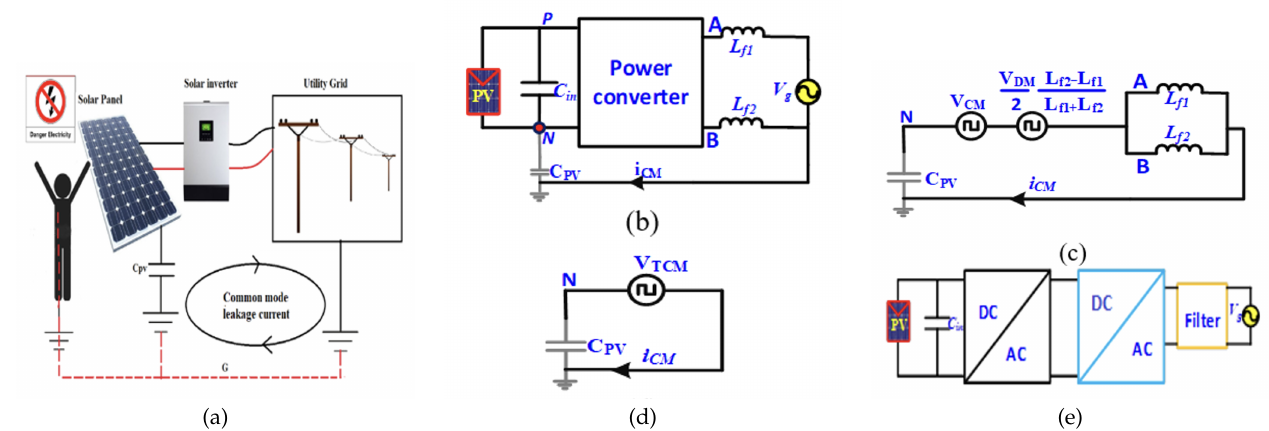
Fig. 1. (a) CMLC Effect (b) Configuration of TLI (c)Common mode model of TLI (d) Reduced common-mode model (e) General structure of Pseudo-DC link